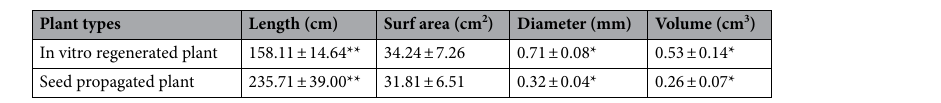
Table 5. Morphological traits in rhizomes of seed propagated and in vitro plants under greenhouse conditions. The data represented mean ± standard error; indicated significant differences between the morphological indexes for the two types are shown** at the 0.01 level;* at the 0.05 level.